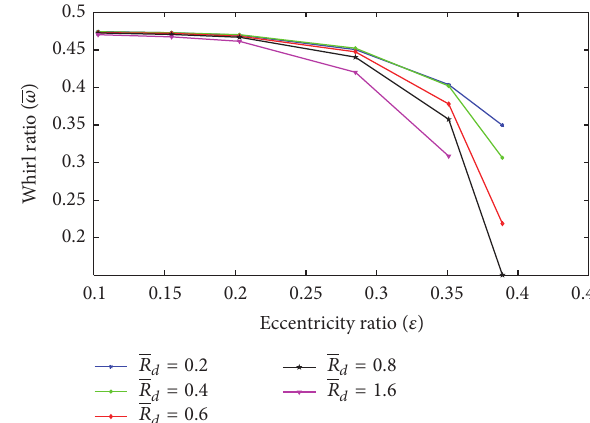
Figure 13: Effect of relief track depth ratio on whirl ratio.